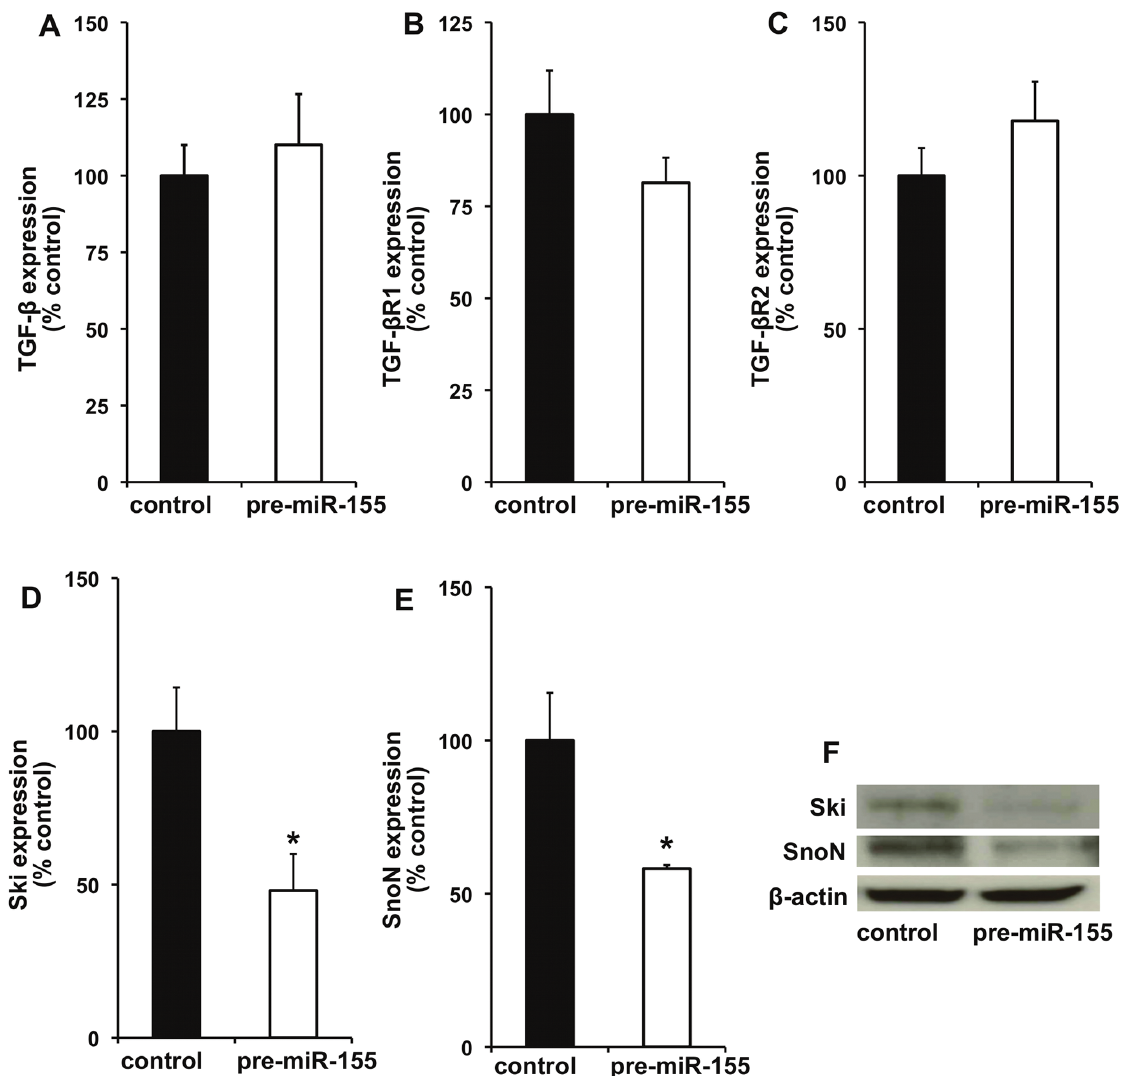
Figure 7. miR-155 over-expression modulates fibrosis-related signaling in mouse cardiac fibroblasts (CFs). CFs were either transfected with miR-155 mimics (pre-miR-155) to over-express miR-155 or negative control mimics (control) for 72 hrs and mRNA expression of various genes were determined by qRT-PCR. miR-155 over-expression (in presence of HGF) did not affect expression of TGF- b ( A ), TGF- b R1 ( B ) and TGF- b R2 ( C ). In contrast mRNA expression of Ski ( D ) and SnoN ( E ) was decreased. *P , 0.05 versus control cells. F . Protein expression of Ski and SnoN in cardiac fibroblasts following over-expression of miR-155 was determined by Western blotting. b -actin served as loading controls. TGF- b indicates TGF- b ; TGF- b R1, TGF-beta receptor type 1; TGF- b R2, TGF-beta receptor type 2; Ski, Sloan-Kettering Institute proto-oncogene; SnoN, Ski-related novel gene, non- Alu-containing.